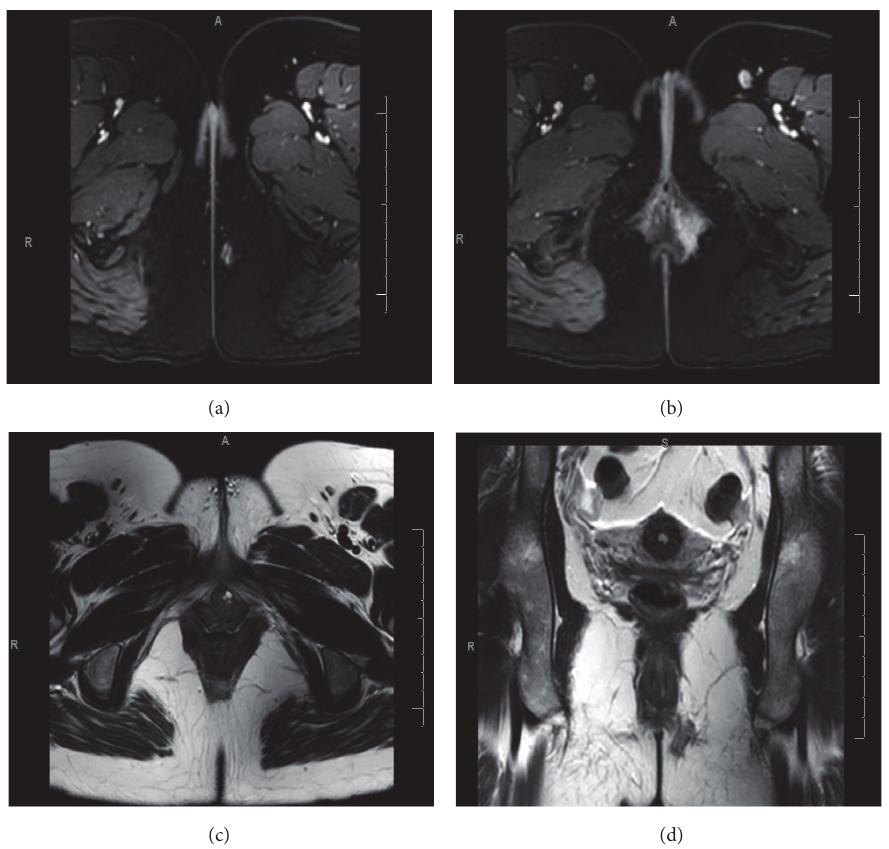
Figure1:(a)T1weightedaxialslicerevealingcaudalmostextentoffistula,(b)T1weightedaxialslicerevealingrostralextentwithsubcutaneous tract in an anteromedial direction, and (c) subcutaneous opening to fistula tract on T2 weighted axial slice. (d) Coronal T2 weighted slice of the fistula